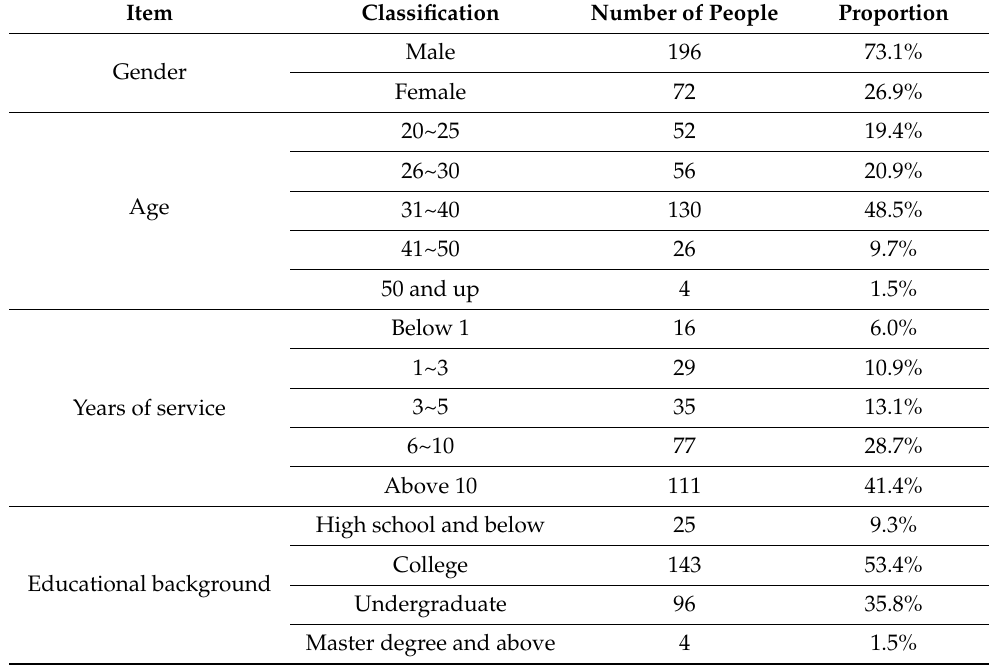
Table 2. Basic information of